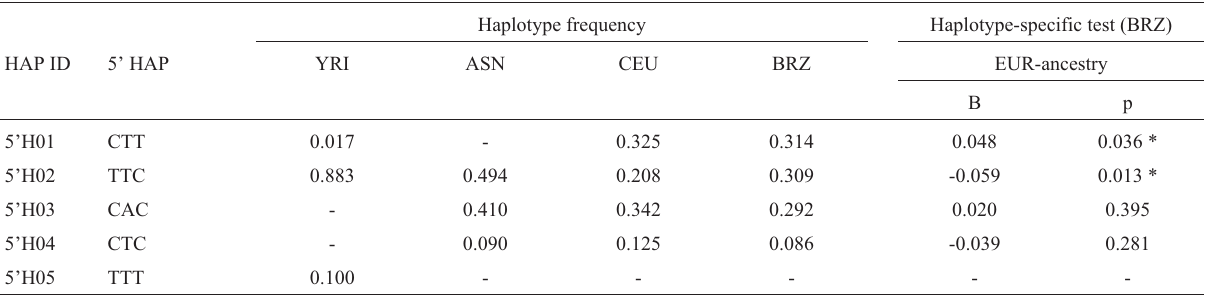
Table 3 - Distribution of the 5’ haplotype frequencies among different populations and the association between Brazilian populations and European an- cestry.